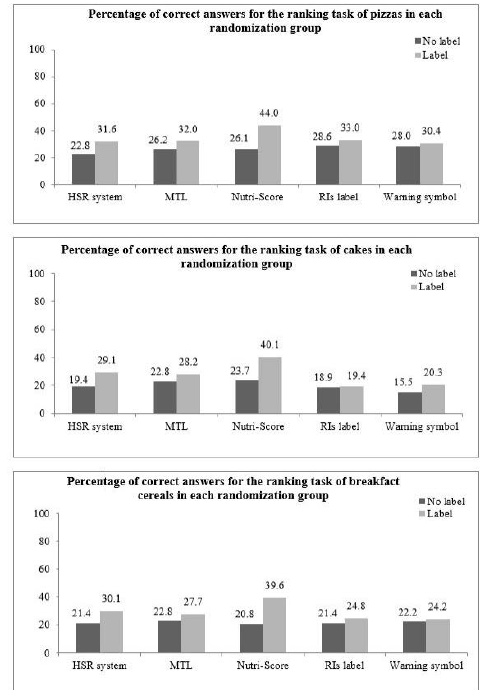
Figure 2. Percentage of correct answers with the change compared to no label, by FoPL and food category, in Italy.